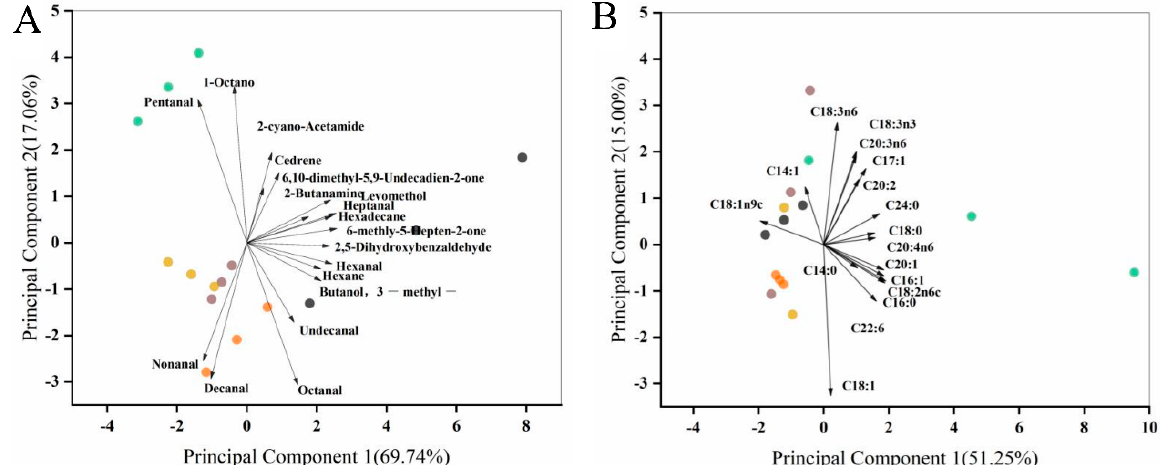
Figure 3. Principal component analysis and loadings of volatile compounds and fatty acids of egg yolk under different ozone treatment times. ( A ) The volatiles; ( B ) fatty acids. Black, green, yellow, purple, and orange spheres represent three parallel groups of samples treated with ozone for 0 min, 10 min, 20 min, 30 min, and 40 min.